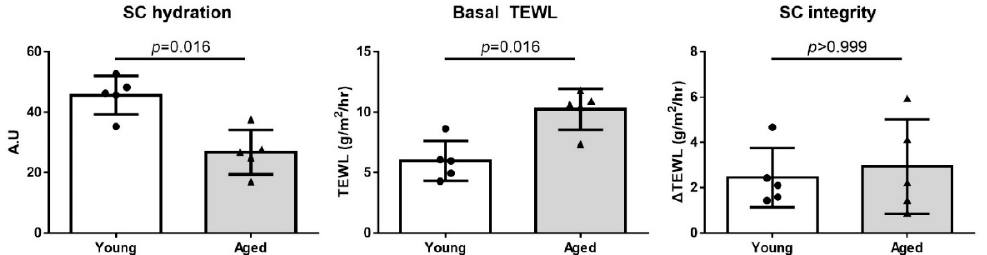
Figure 3. Skin barrier function in the skin of young and aged hairless mice. The aged mice had lower SC hydration and higher basal TEWL, but there was no difference in SC integrity between the groups. SC integrity was defined as the change in TEWL after 15 rounds of D-Squame disc tape stripping. The data are presented as the means ± SD. SC, stratum corneum; TEWL, transepidermal water loss.